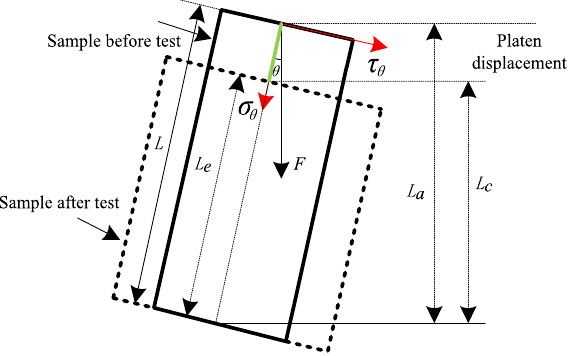
Figure 18. Calculation principle of shear and compression stress